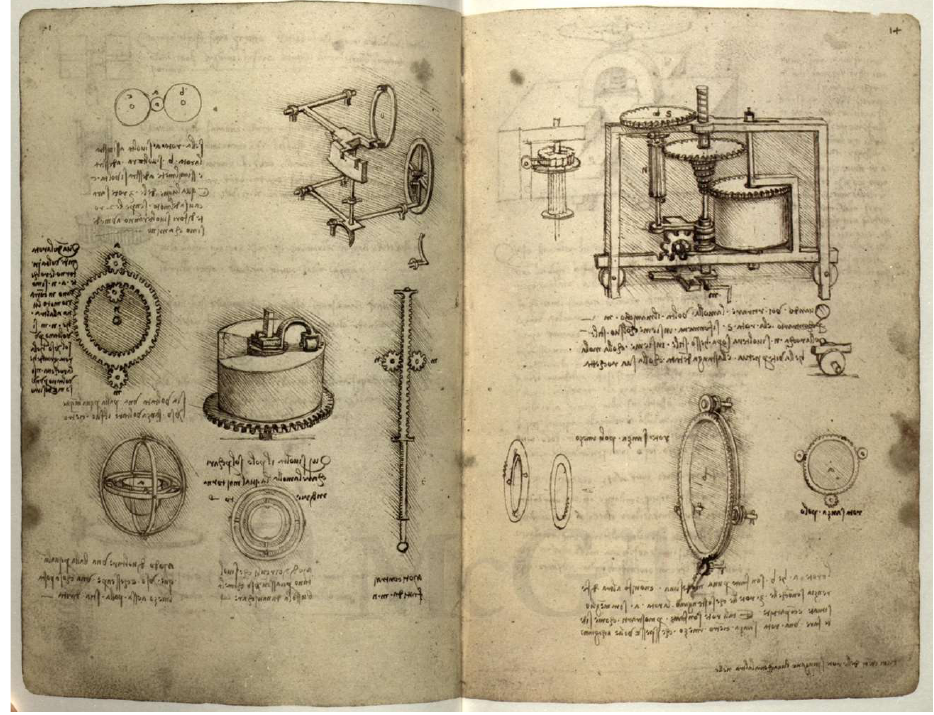
Figure 4. Leonardo da Vinci, Codex Madrid I, Folio 13v. The gimbal in Leonardo’s drawings alludes to a mechanism used on ships to hold a mariner’s compass in place.